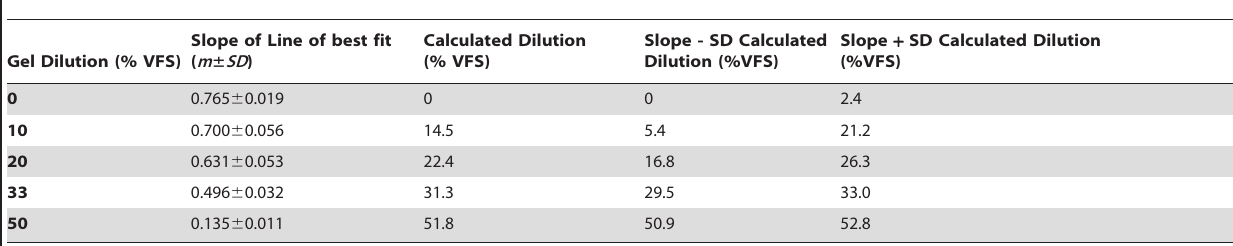
Table 3. Error Analysis of dilution calculation derived from the slope of the line of best fit in Figure 3. SD= standard deviation.